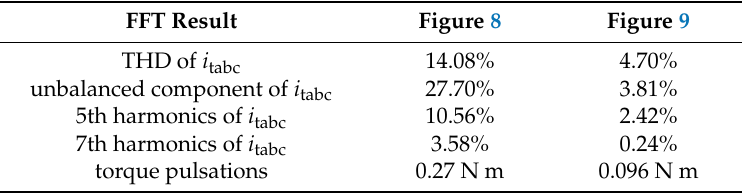
Figure 15. Experimental results of the MRSMC with active power step. Table 4. Comparison with Figures 13 and